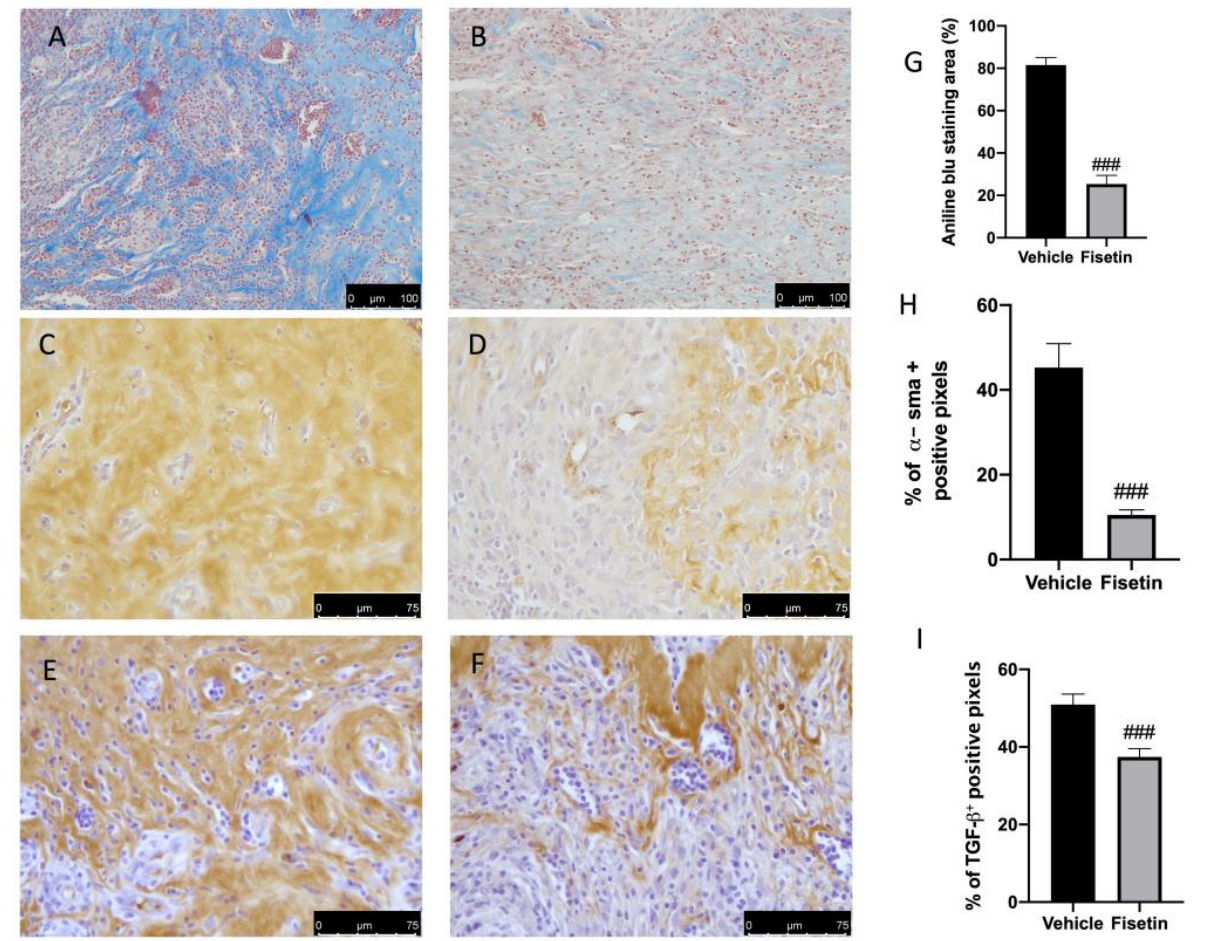
Figure 3. Fisetin administration on fibrosis: Masson trichrome staining for endometriosis + vehicle ( A ) +fisetin ( B ). Immunohistochemical analysis of α -sma and TGF- β for vehicle ( C , E ), fisetin ( D , F ). Aniline blue stain area ( G ); Immunohistochemical results are expressed as % of positive pixels ( H , I ). Figures are representative of at least three independent experiments. Values are means ± SEM of 6 animals for each group. Scale bar: 75 μm. ### p < 0.001 vs. vehicle.